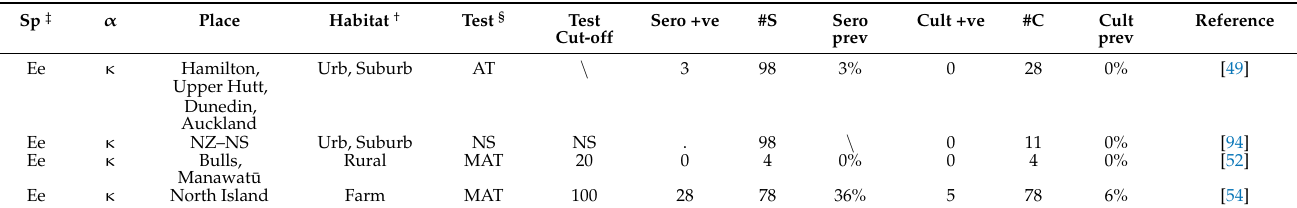
Table 2. Summary of the published studies investigating Leptospira borgpetersenii serovar Ballum in wild species in New Zealand. For each study and species (Sp) are indicated: the numbers of seropositive animals (Sero + ve) and animals tested by serology (#S), the seroprevalence (Seroprev), the numbers of culture-positive animals (Cult + ve) and animals tested by culture (#C), and the culture prevalence (Cult prev). An extended version of this table with information on other serovars and studies not testing for Ballum [42–48,56,99–107] is available in the Supplementary Materials